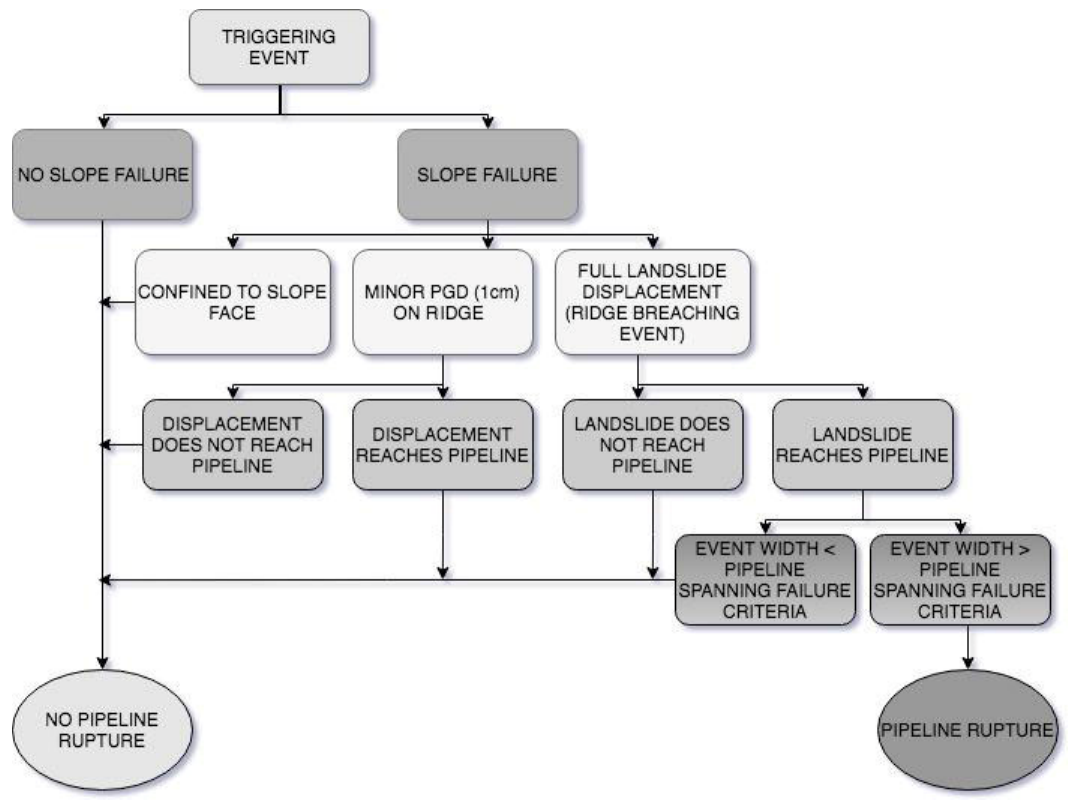
Figure 15. Event tree illustrating the event sequences involved in generating pipeline rupture considered for hazard assessment.